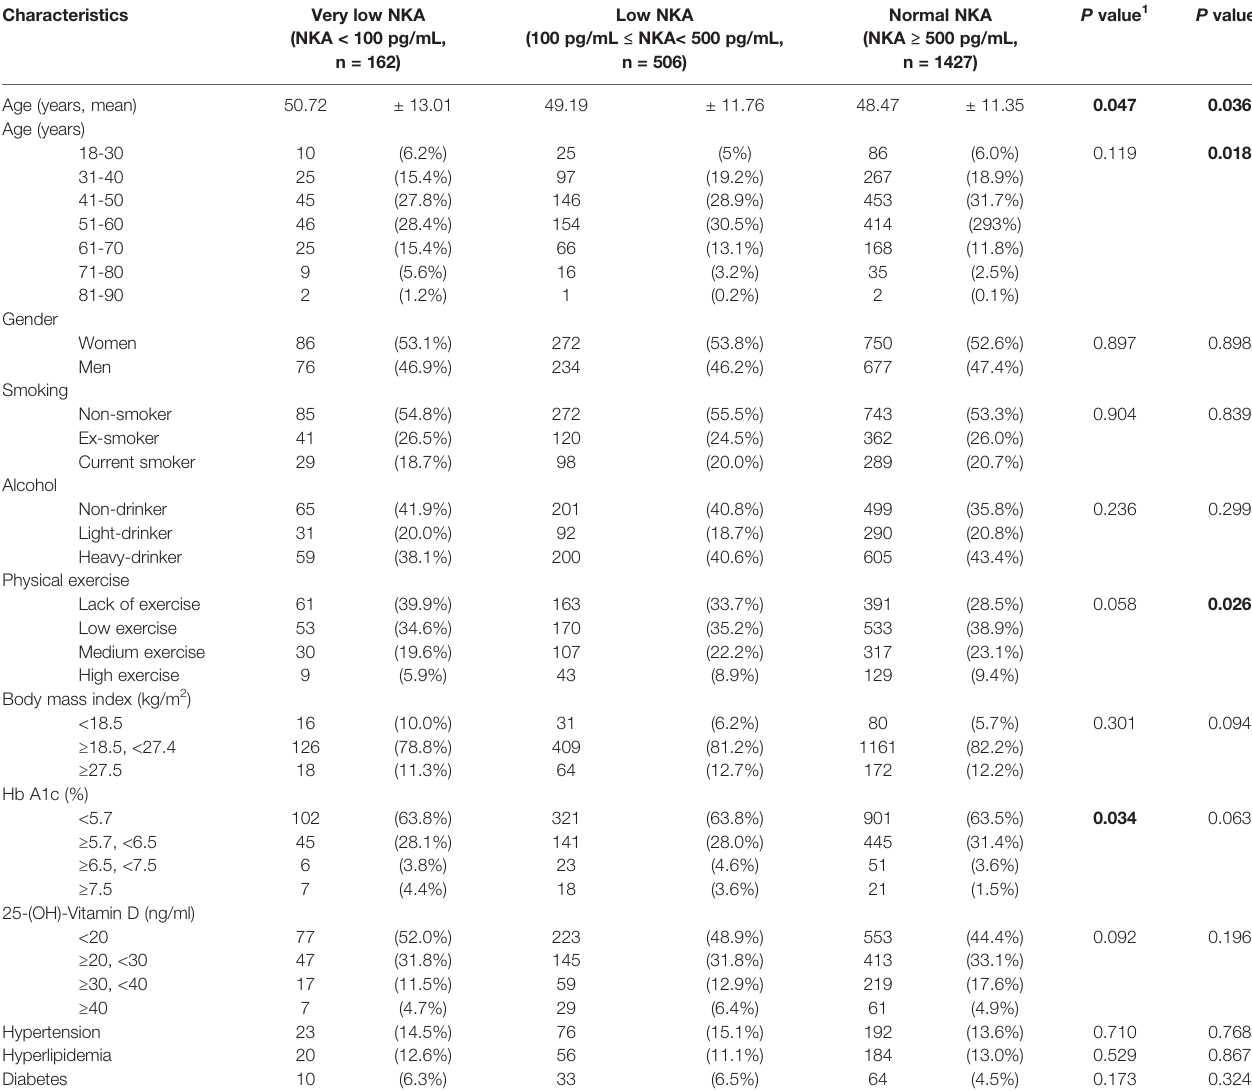
TABLE 1 | Population characteristics according to